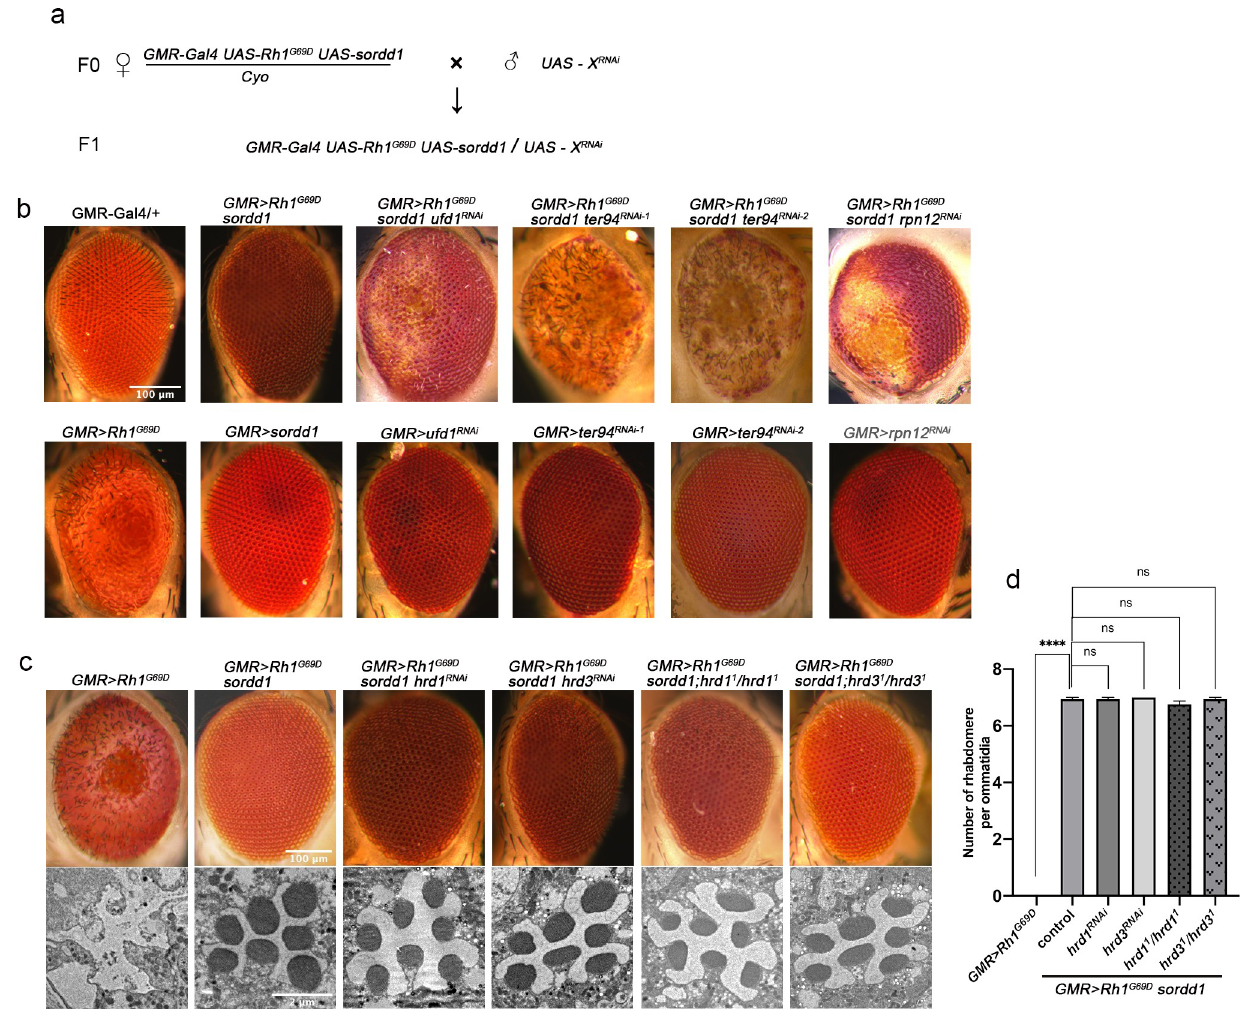
Fig 3. Degradation of Rh1 G69D by SORDD1 is dependent on VCP and proteasome, not dependent on the HRD1 complex. (a) Schematic diagram of the genome-wide RNAi screen for modifiers of SORDD1-mediated Rh1 G69D degradation. (b) Light photomicrographs show the adult eye was damaged when ufd1 ( GMR > Rh1 G69D sordd1 ufd1 RNAi : GMR-Gal4 UAS-Rh-1 G69D UAS-sordd1/+;UAS-ufd1 RNAi /+ ), ter94 ( GMR > Rh1 G69D sordd1 ter94 RNAi-1 : GMR-Gal4 UAS-Rh1 G69D UAS-sordd1/+;UAS-ter94 RNAi-1 /+ and GMR > Rh1 G69D sordd1 ter94 RNAi-2 : GMR-Gal4 UAS-Rh1 G69D UAS-sordd1/+;UAS- ter94 RNAi-2 /+ ) and rpn12 ( GMR > Rh1 G69D sordd1 rpn12 RNAi : GMR-Gal4 UAS-Rh1 G69D UAS-sordd1/+;UAS-rpn12 RNAi /+ ) were knocked down by shRNA in GMR > Rh1 G69D sordd1 background. Expressing ufd 1 RNAi ( GMR > ufd1 RNAi : GMR-Gal4 /+;UAS-ufd1 RNAi /+ ), ter94 RNAi ( GMR > ter94 RNAi : GMR-Gal4 /+; UAS-ter94 RNAi /+ ) and rpn12 RNAi ( GMR > rpn12 RNAi : GMR-Gal4 /+;UAS-rpn12 RNAi /+ ) alone have no obvious phenotype. Scale bar, 100 μ m. (c) Mutations in hrd1 or hrd3 had no effect on eye morphology of GMR > Rh1 G69D , sordd1 flies, both under light microscopy (top) and transmission electron microscopy (bottom). Homozygous null mutants of hrd1 or hrd3 were generated using “ ey-flp/hid ” system. Genotypes: GMR > Rh1 G69D sordd1 hrd1 RNAi ( GMR-Gal4 UAS-Rh-1 G69D UAS-sordd1/+;UAS-hrd1 RNAi /+ ), GMR > Rh1 G69D sordd1;hrd1 1 /hrd1 1 ( ey-flp;GMR-Gal4 UAS-Rh1 G69D UAS-sordd1/+; FRT82B hrd1 1 / FRT82B GMR-hid CL B ), GMR > Rh1 G69D sordd1 hrd3 RNAi ( GMR-Gal4 UAS-Rh-1 G69D UAS-sordd1/+;UAS-hrd3 RNAi /+ ) and GMR > Rh1 G69D sordd1;hrd3 1 / hrd3 1 ( ey-flp;GMR-Gal4 UAS-Rh1 G69D UAS-sordd1/+;FRT82B hrd3 1 /FRT82B GMR-hid CL ). LM scale bar, 100 μ m, TEM scale bar, 2 μ m. (d) Quantification of rhabdomere numbers per ommatidia in c; error bars indicate SEM; sections from three flies of each genotype were used for quantification; ns, not significant (one-way ANOVA, Sidak’s multiple comparisons